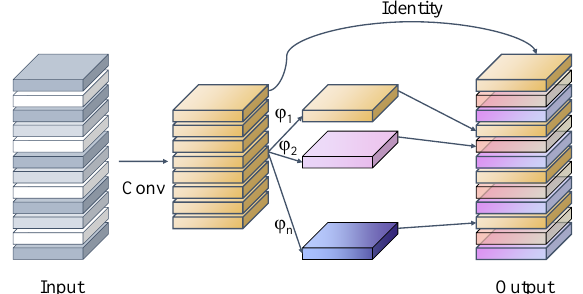
Figure 4. The Ghost convolution